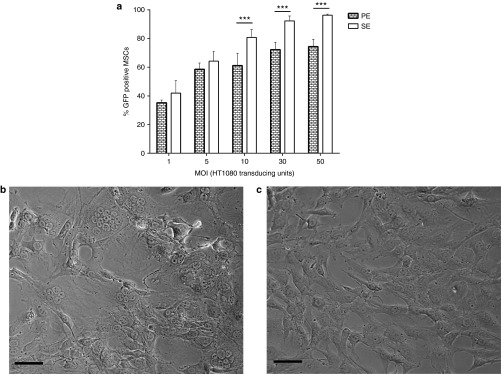
Effect of foamy virus vector (FVV) envelope on mMSC transduction efficiency and cytopathic effect. (a) The percent of GFP expressing mMSCs after 1 passage post-transduction with PGK-GFP enveloped with PFV Env (brick patterned) or SFVmac Env (white) at different multiplicity of infection (MOIs) was determined by flow cytometry. The mean + SD of biological triplicates is shown. Significant differences between means at each MOI are indicated by asterisks according to the P value as determined by two-way analysis of variance with Bonferroni's multiple comparisons test. (b,c) Photomicrographs of MSCs 20 hours after vector addition. Scale bar = 50 µm. (b) Transduced at MOI 30 using PFV Env; (c) Transduced at MOI 30 using SFVmac Env.